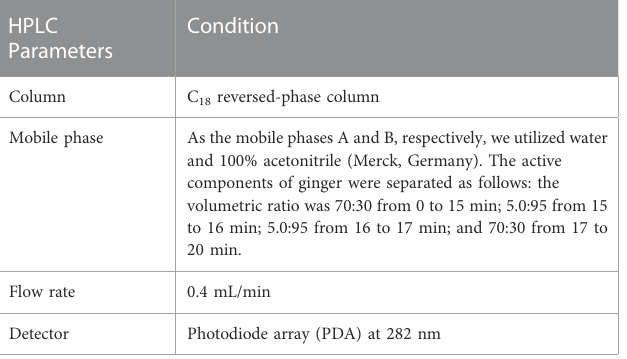
TABLE 1 HPLC parameters for chromatographic